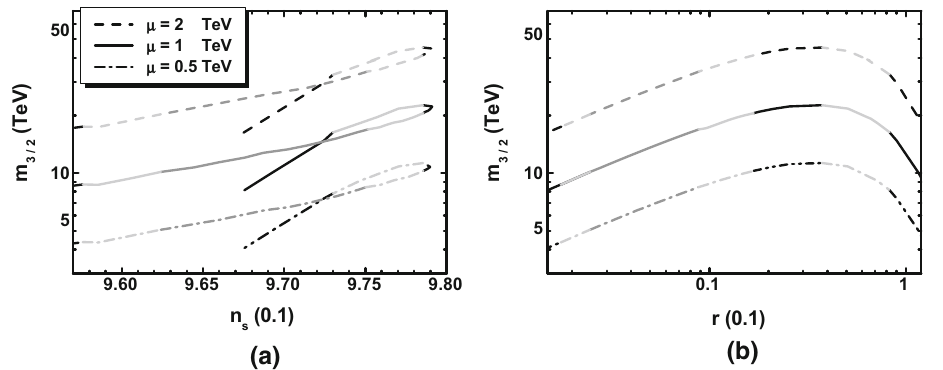
Fig. 5 The gravitino mass m 3 / 2 versus n s ( a ) and r ( b ) for λ μ = 10 − 6 , a 3 / 2 = 1, K = K 2 or K 3 with N X = 2 and μ = 0 . 5 TeV (dot-dashed line), μ = 1 TeV (solid line), or μ = 2 TeV (dashed line). The color coding is as in Fig. 3